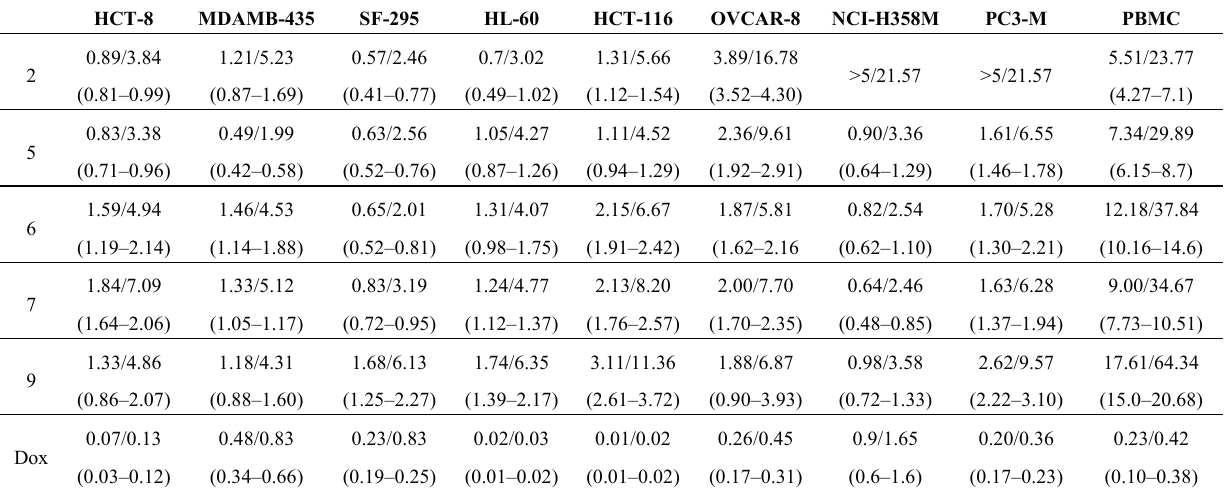
Table 2. Cytotoxicity (IC ) of the aminonaphthoquinones (ANPQ) in eight cell lines 50 tumour and normal cell line (PBMC) after 72 h exposure, obtained by nonlinear regression for all cell lines from three independent experiments. The values are presented µg·mL − 1 /µmol·L − 1 and their respective confidence intervals (95%